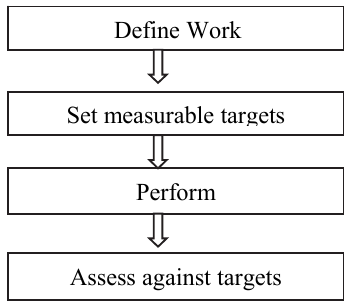
Source: Bratton & Gold, 2007:287. (Adapted from Randell,